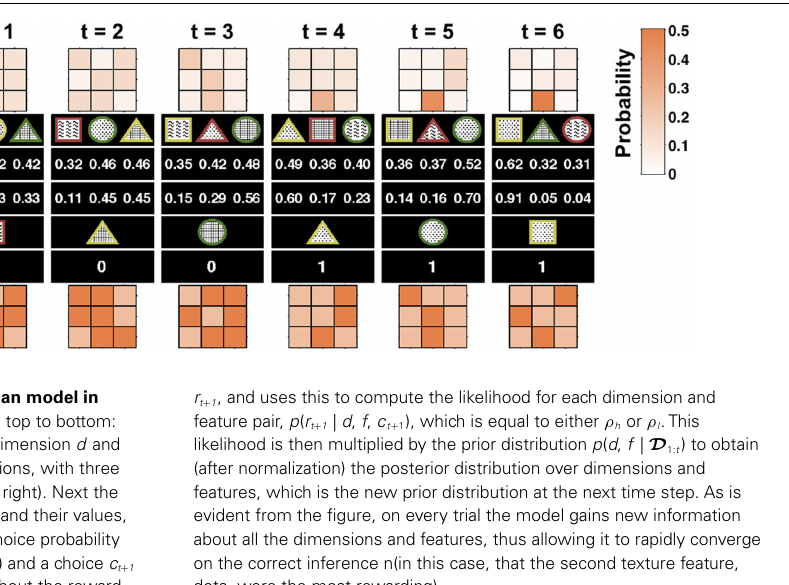
r t + 1 , and uses this to compute the likelihood for each dimension and feature pair, p ( r t + 1 | d , f , c t + 1 ), which is equal to either ρ h or ρ l .This likelihood is then multiplied by the prior distribution p ( d , f | D 1: t ) to obtain (after normalization) the posterior distribution over dimensions and features, which is the new prior distribution at the next time step. As is evident from the figure, on every trial the model gains new information about all the dimensions and features, thus allowing it to rapidly converge on the correct inference n(in this case, that the second texture feature, dots, were the most